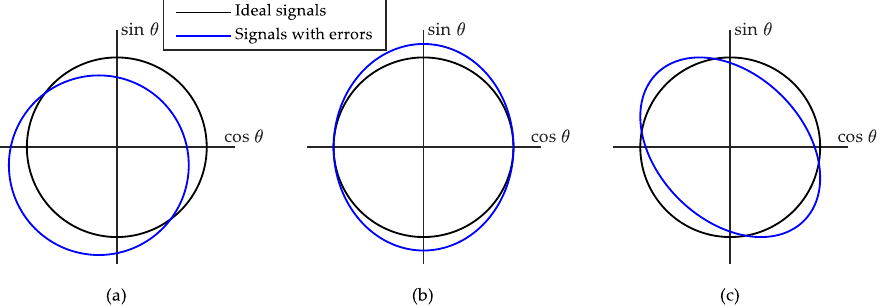
Figure 13. Three possible errors in the output signal of the Sin-Cos encoder. ( a ) Offset. ( b ) Different gains. ( c ) Adquisition delay.